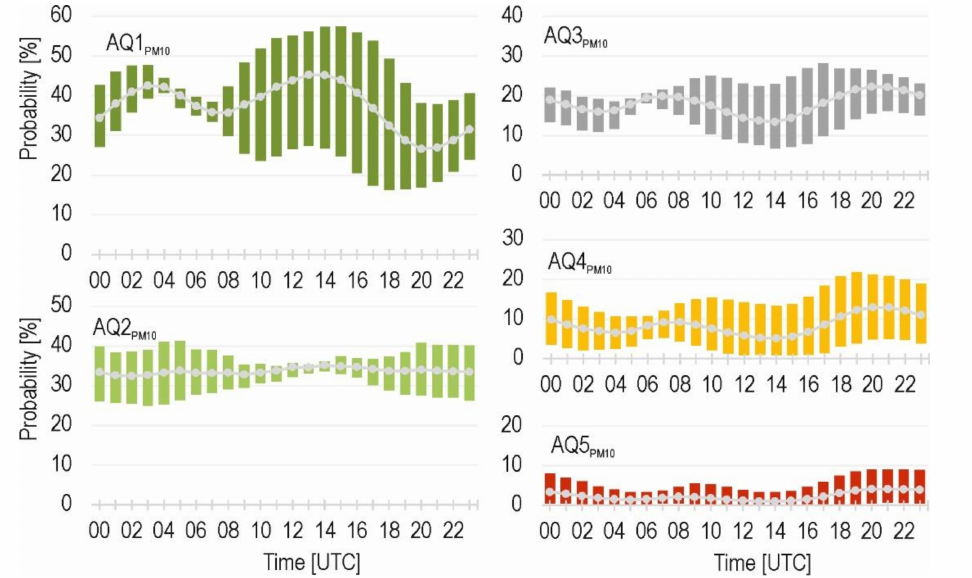
Figure 6. Daily variability in probability of air quality classes (AQ) and their seasonal variability; grey dots linked with line represent probability calculated based on data for the entire year, vertical bars—seasonal variability in probability, the bottom of the bars—minimum seasonal probability, top of the bars—maximum seasonal probability (usually in winter), daily courses in AQ calculated as arithmetical average from 4 monitoring stations (Sosnowiec, Katowice, Zabrze, Gliwice). Time: 12 UTC = 13:20 local mean solar time.